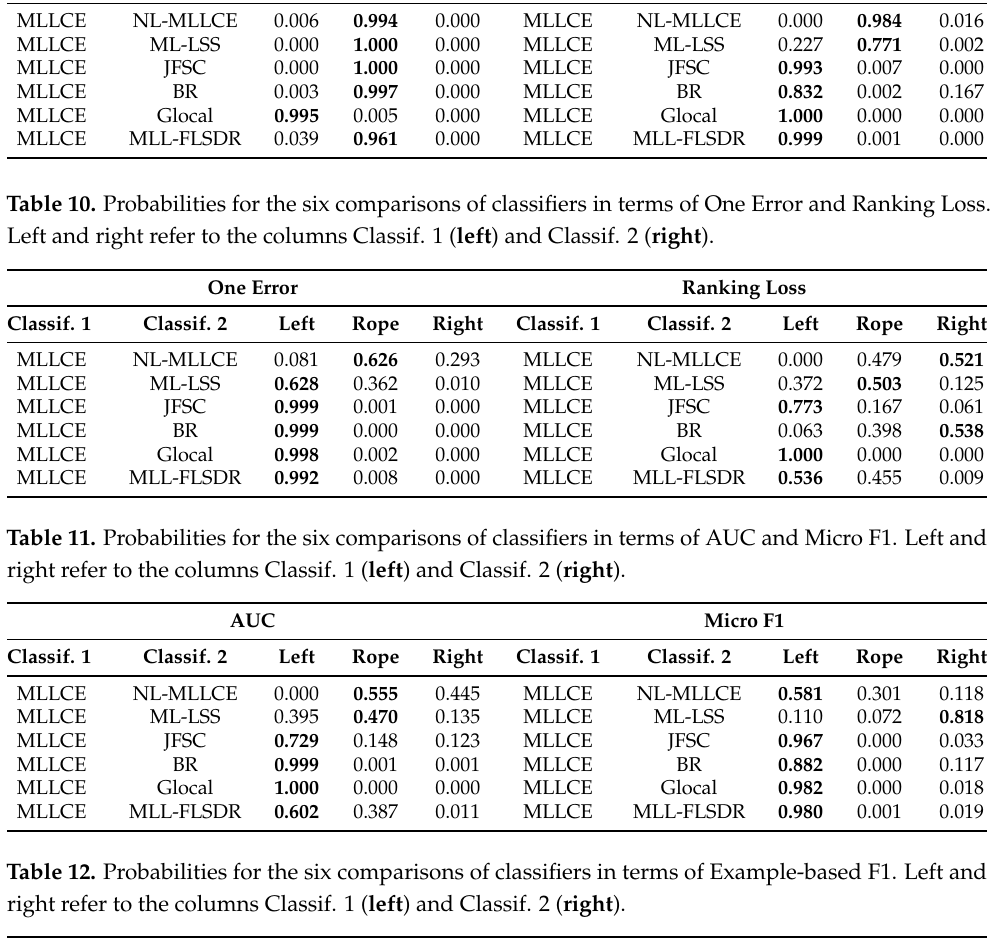
Table 9. Probabilities for the six comparisons of classifiers in terms of Hamming Loss and Average Precision. Left and right refer to the columns Classif. 1 ( left ) and Classif. 2 ( right ). Hamming Loss Average Precision Classif. 1